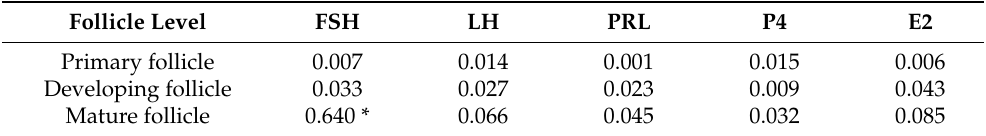
Table 4. Correlation analysis between serum hormone and OVR expression in different follicle levels of Wanxi White goose.